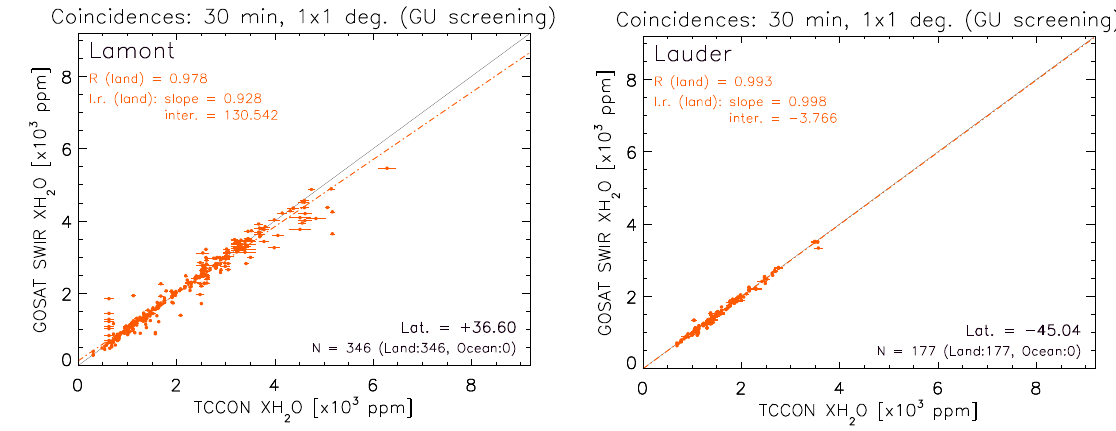
Figure 6. Scatter plot of the GOSAT TANSO-FTS XH 2 O and coincident TCCON soundings (criteria of ± 30min and ± 1 ◦ in latitude/longitude) at the Lamont (left) and Lauder (right) TCCON sites. All coincidences were found for TANSO-FTS land